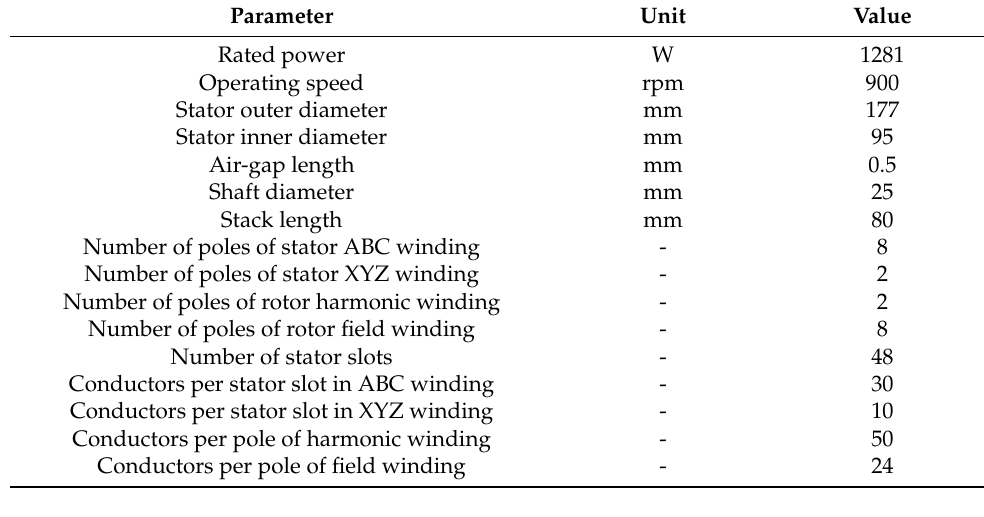
Table 1. Design parameters of the proposed SHSM.